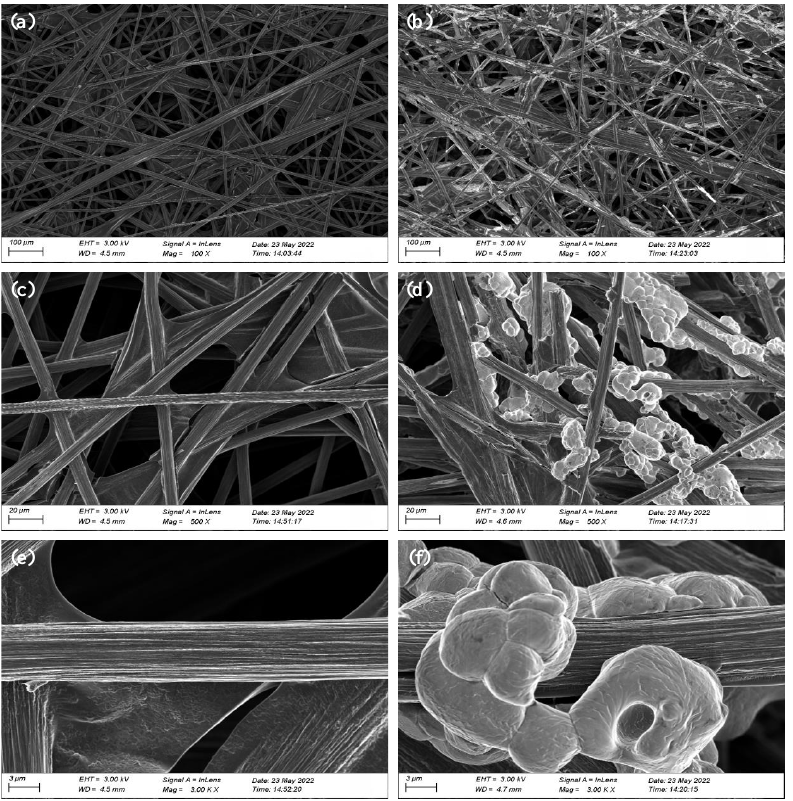
Figure 3. SEM images: ( a ) CP 100 × ; ( b ) rGO/CP 100 × ; ( c ) CP 500 × ; ( d ) rGO/CP 500 × ; ( e ) CP 3000 × ; ( f ) rGO/CP 3000 × .